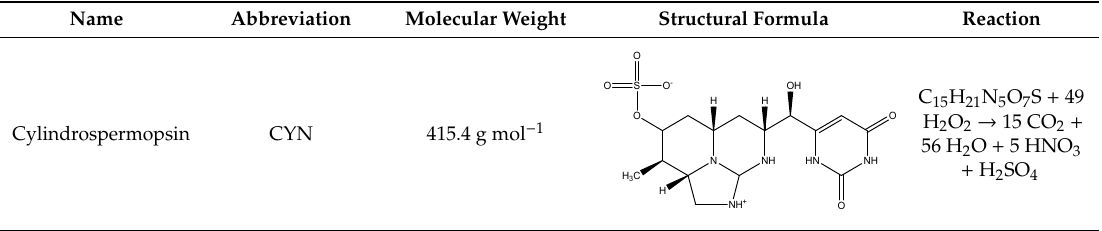
Table 2. Nomenclature, molecular weight, structural formula and CWPO reaction stoichiometry of CYN.